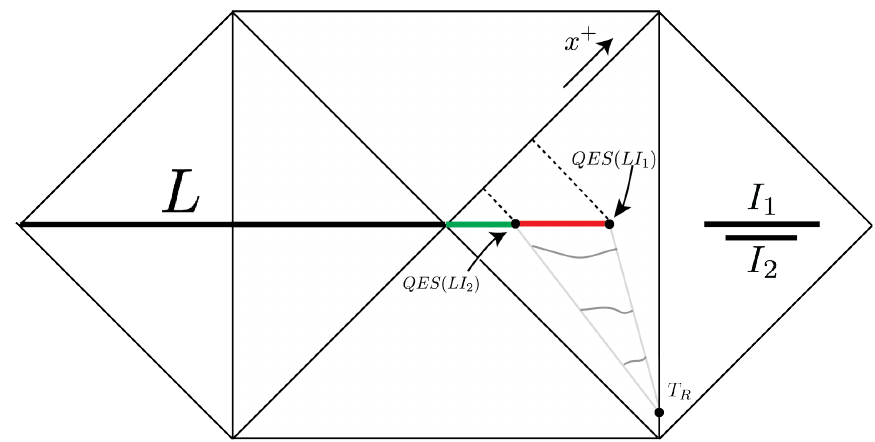
Figure 7 . We can use our calculations of the fidelity (susceptibility) to infer the longitudinal extent of the string. For a fixed time T at which we throw in the probe, we can find two different regions R LI 1 and LI 2 for which the object is definitely in neither the entanglement wedge of LI 1 nor the entanglement wedge of LI . This is illustrated 2